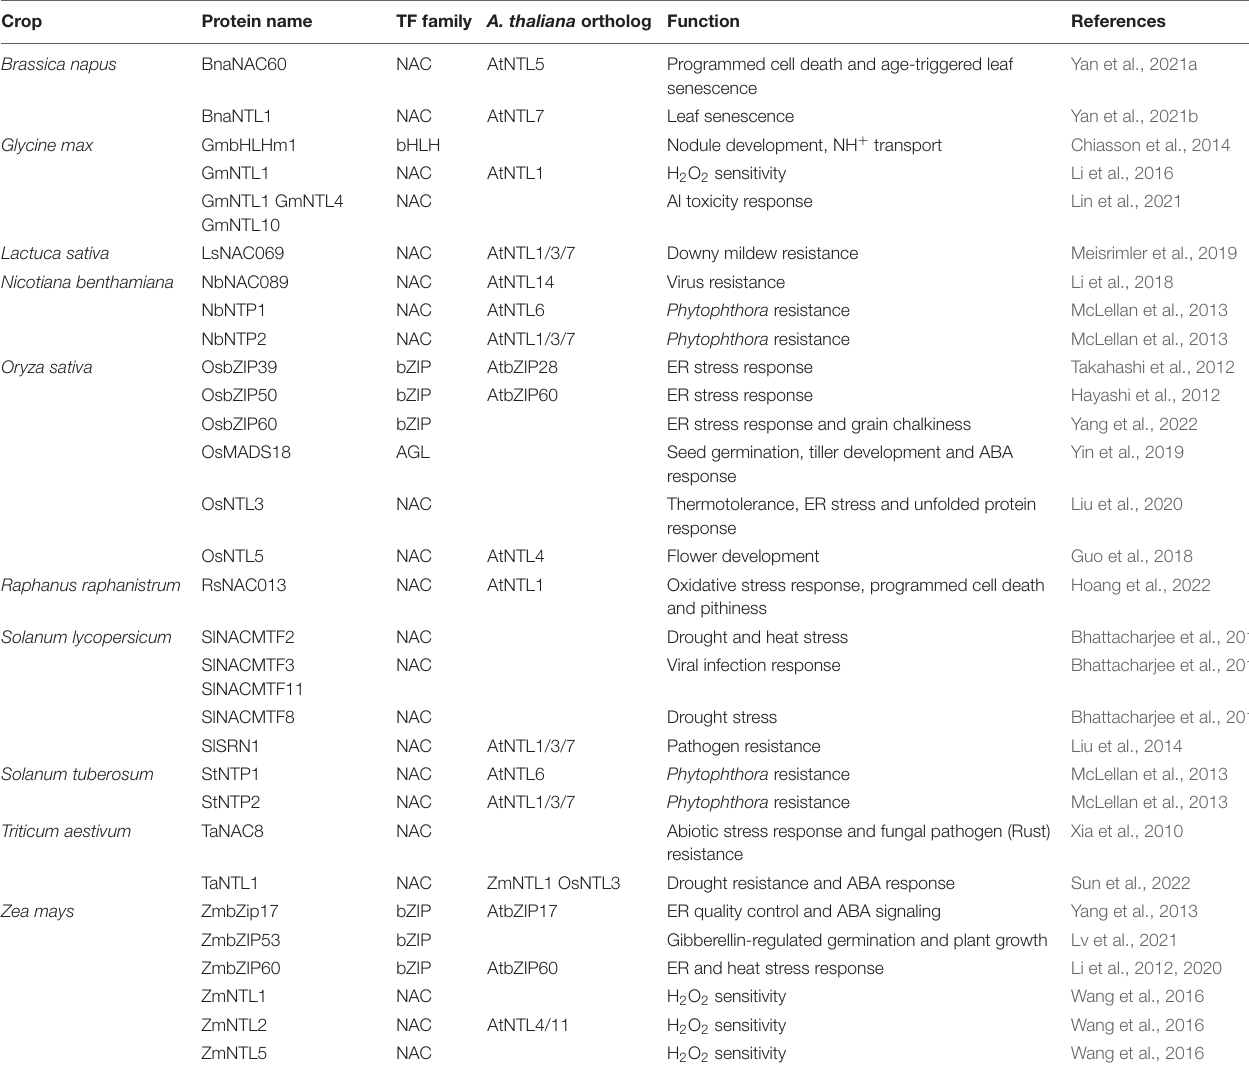
TABLE 3 | Overview of MB-TFs functions in crop development and stress responses.